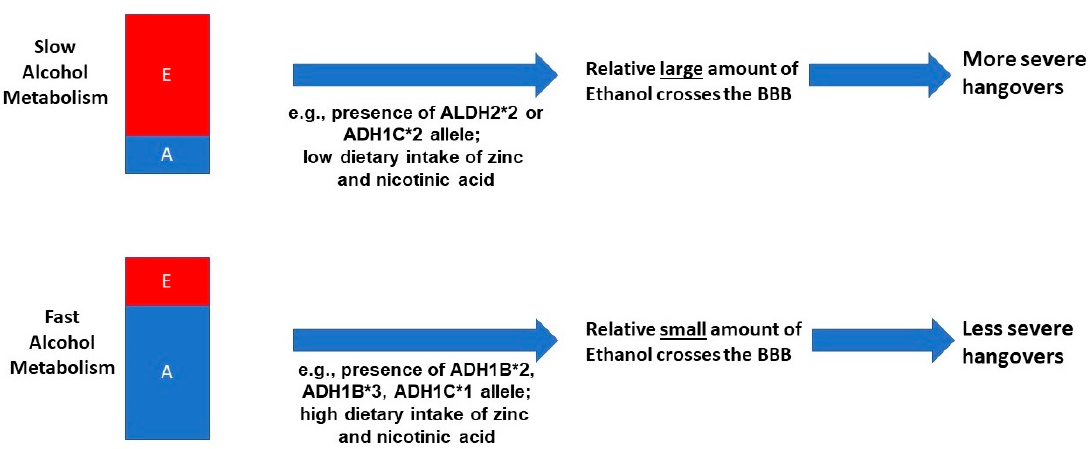
Figure 3. The impact of alcohol metabolism rate on hangover severity. Abbreviations: E = ethanol, A = acetaldehyde, BBB = blood brain barrier, ALDH = aldehyde dehydrogenase.